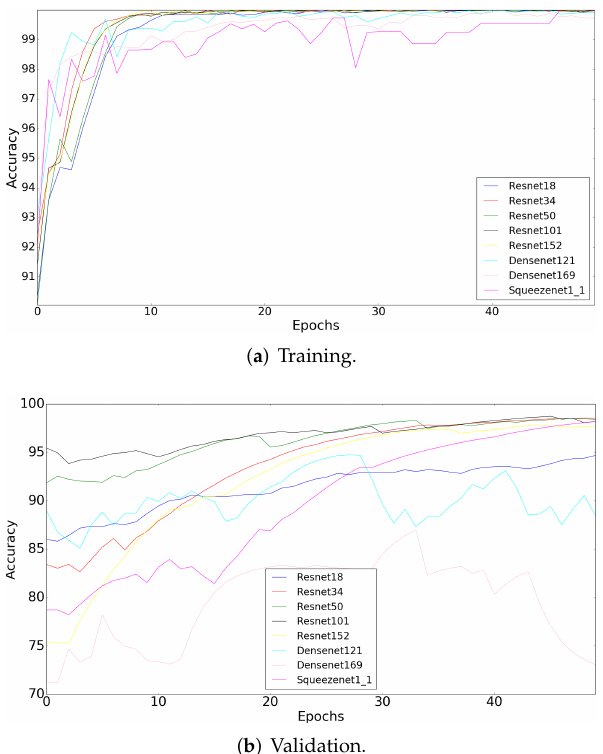
Figure 6. ( a ) Training and ( b ) validation accuracy across epochs of the compared models based on different modified architectures. Interestingly, deeper models performed worse,with the validation accuracy decreasing together with the network